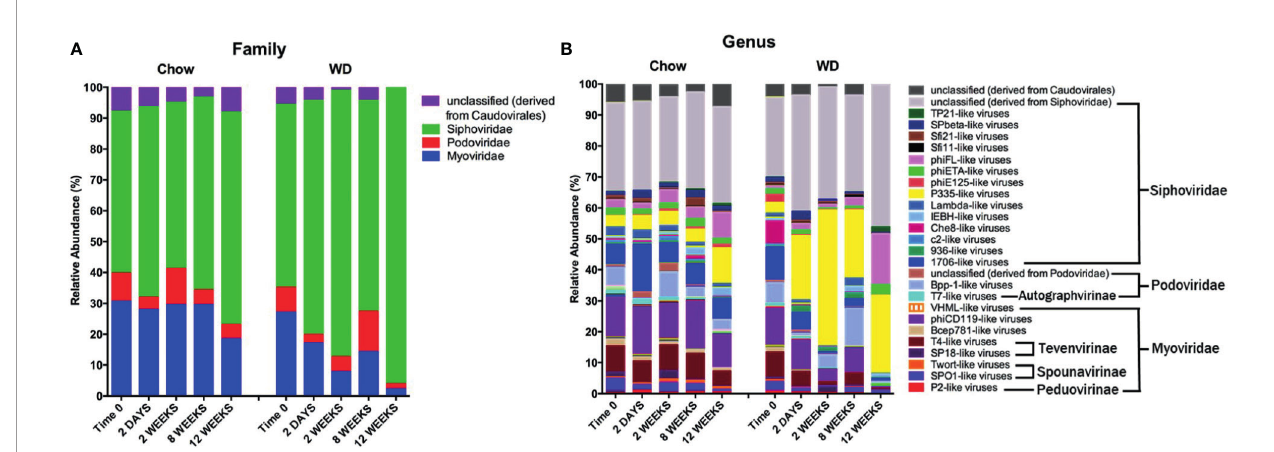
FIGURE 6 | Changes in relative abundance of bacteriophage composition after administration of the Western diet. (A) Family and (B) Genus level viral composition derived from the order Caudovirales in mice fed Chow or WD at 2 days, 2, 8 and 12 weeks of dietary exposure. Data shown are based on those families belonging to the order Caudovirales. The mean relative abundances (%) of viral families are shown. Statistical results outlined in Tables S4 , S5